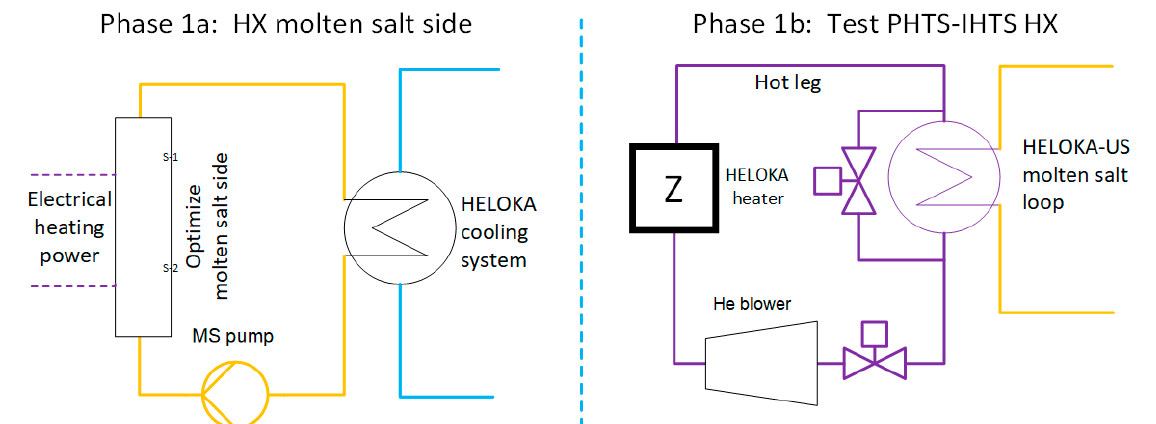
Figure 6. HELOKA-US Phase 1 subdivided into HX qualification and He HX plus blower tests.